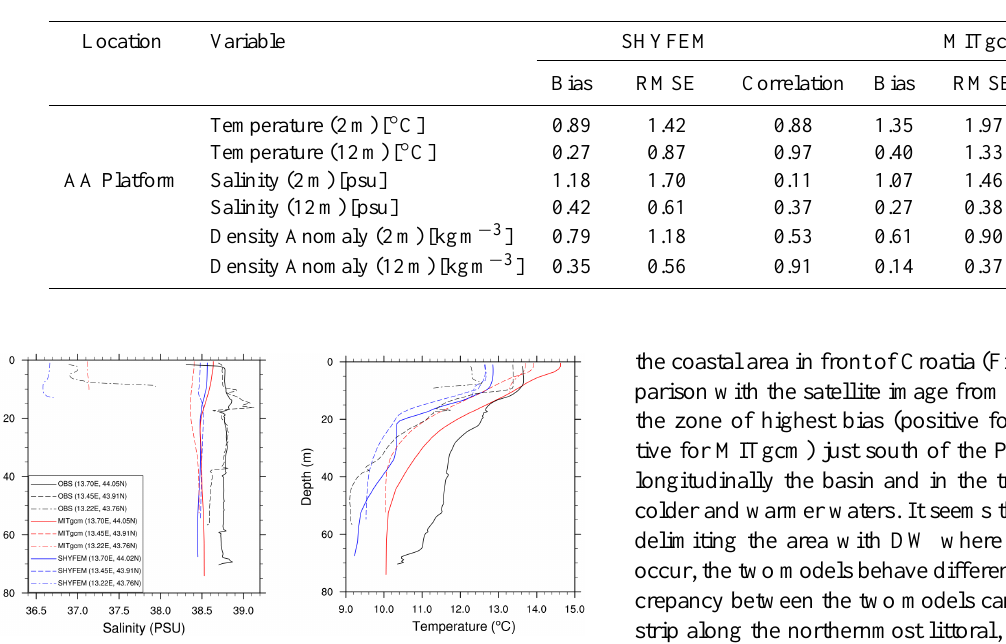
Table 2. Statistical analysis of simulated water temperature and salinity time series computed at the Acqua Alta CNR Platform. Analyses provided are the difference between mean of observations and simulations (Bias), the root mean square error (RMSE), and the correlation.